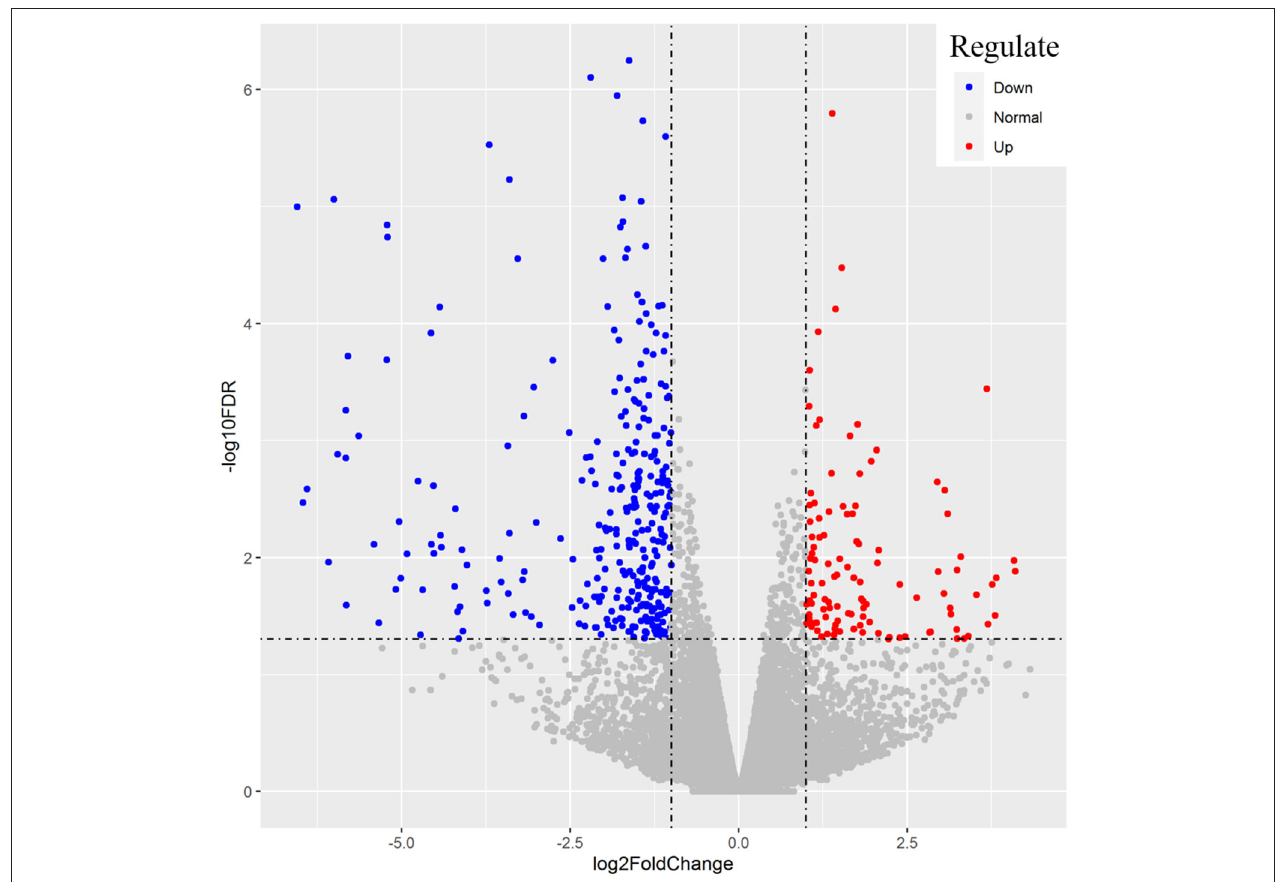
FIGURE 3 | Representation of the differentially expressed genes between the H and L groups. The x-axis values are the log2 (fold change) and the y-axis values are –log10 FDR. Genes with higher expression levels in H group compared with L group were denoted as “up-regulated” and indicated in red, while those with lower expression levels in H group were “down-regulated” and indicated in